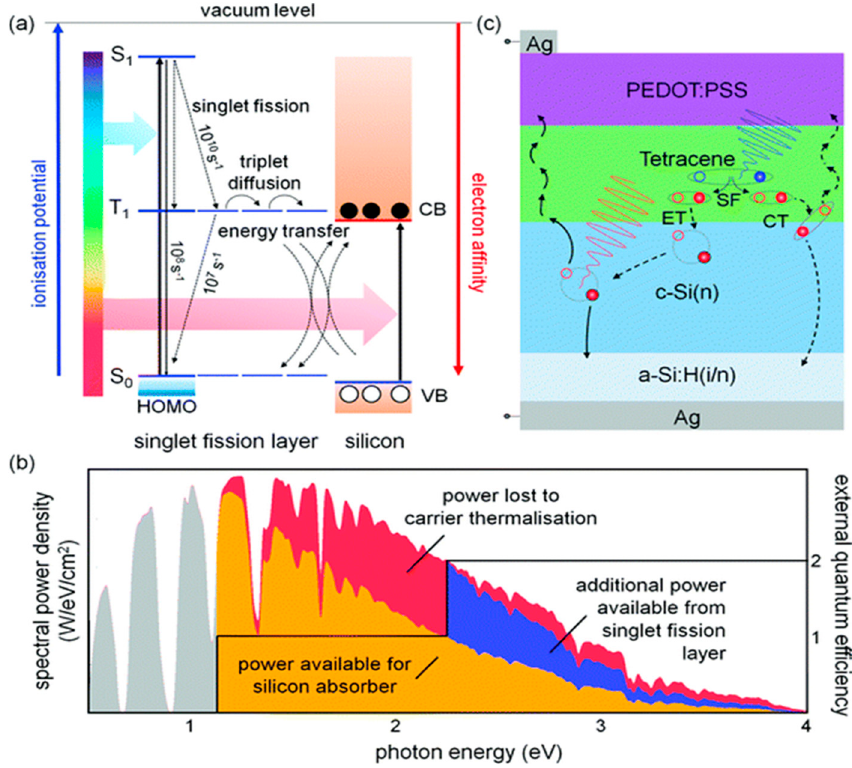
Figure 16. ( a ) Energy level diagram showing an organic SF layer situated as a selective absorber in a silicon − based solar cell. ( b ) Solar spectrum with shaded portions representing the approximate power available for electrical conversion in an ideal silicon solar cell (gold), the power lost to carrier thermalization (red) and sub-band gap transmission (grey), and the additional power made available by employing a matched SF layer (blue). The external quantum efficiency of the cell is drawn in black. ( c ) Solar cell structure utilized in this work (not to scale). Reprinted with permission from Ref. [101]. Copyright 2018, The Royal Society of Chemistry.